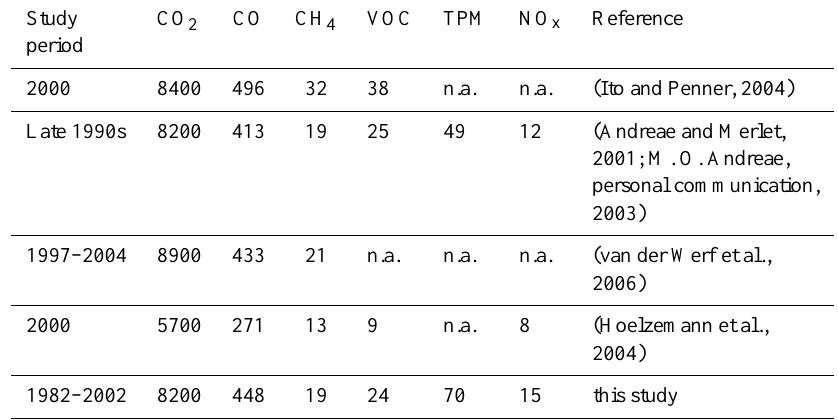
Table 3. Comparison of estimates of trace gas emissions (Tgyr − 1 ). Study CO 2